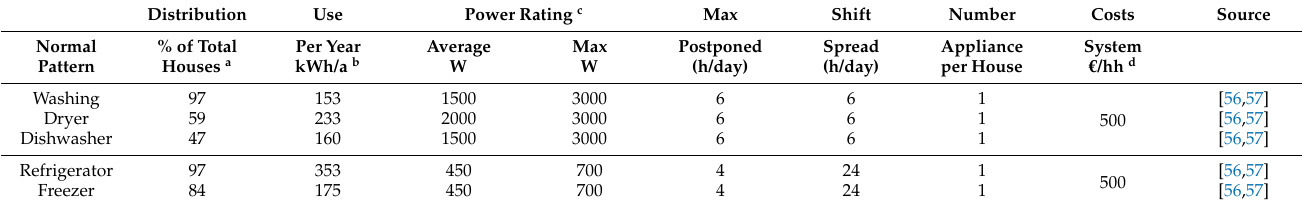
Table 2. Main values installed smart appliances average Dutch